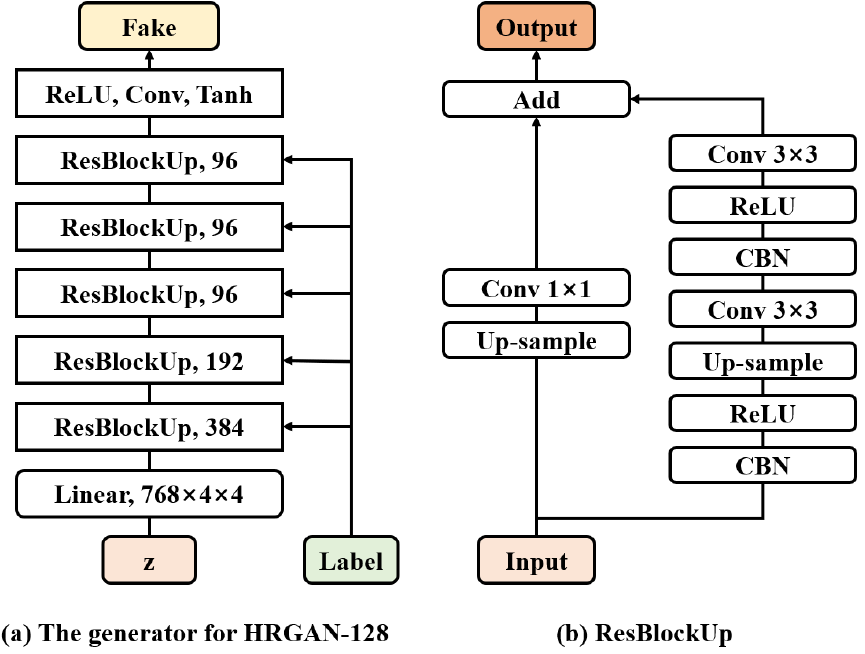
Figure 3. The structures of ( a ) the HRGAN-128 generator and ( b ) the up-sampling residual block. Each up-sampling residual block contains the main path and a shortcut path,